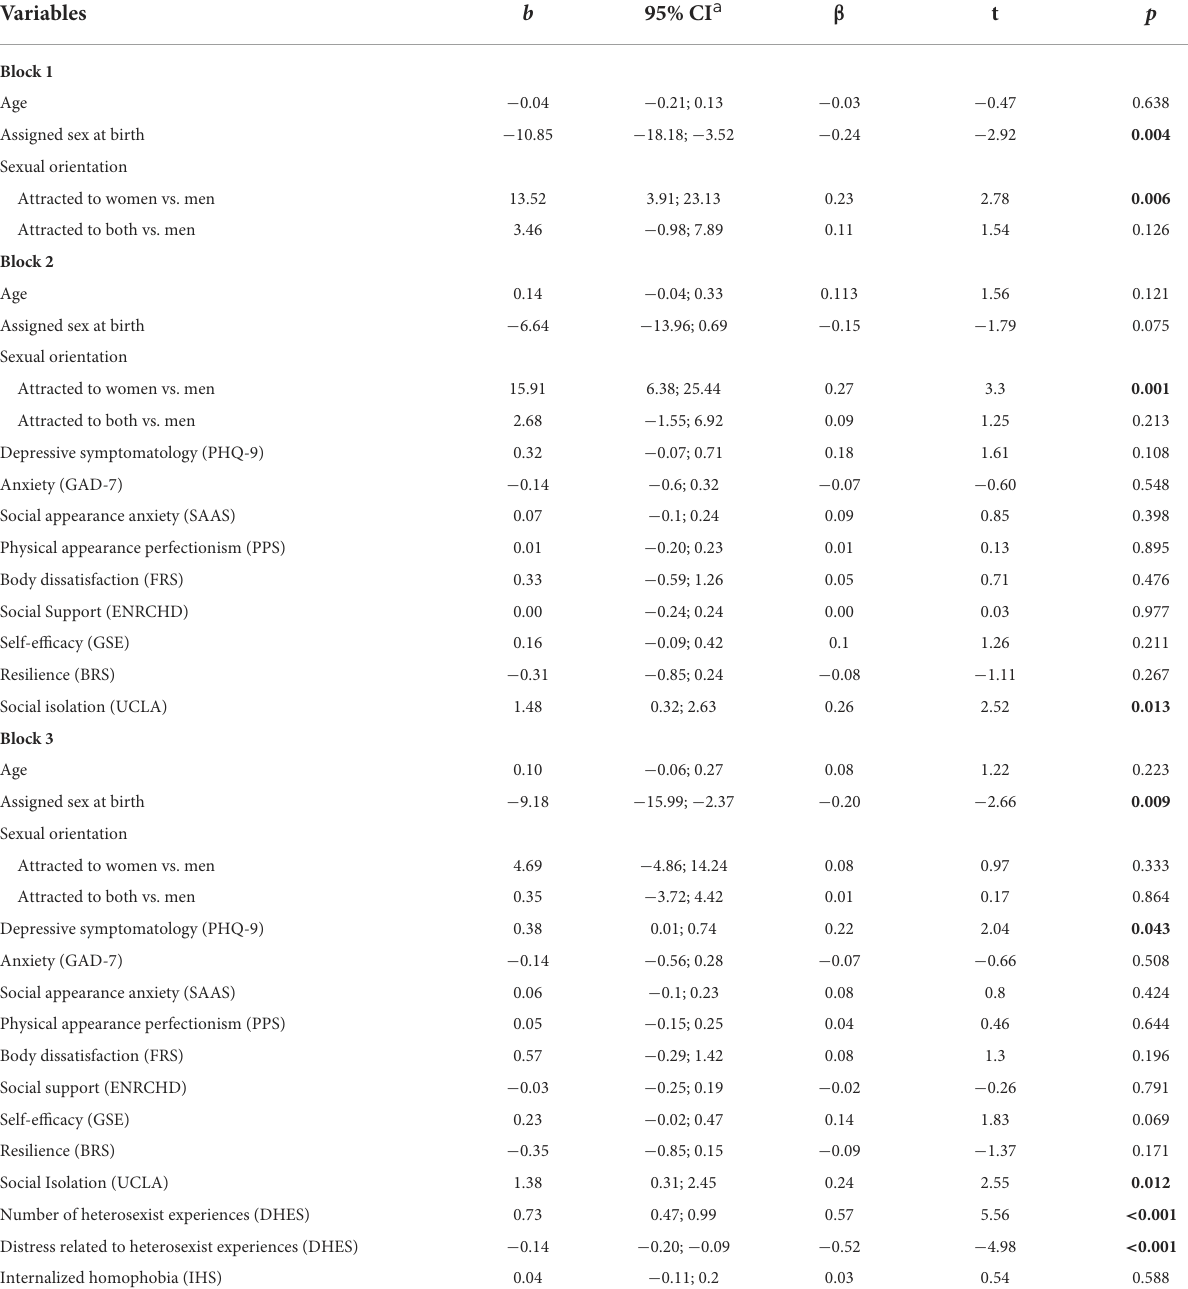
TABLE 2 Summary of the multiple hierarchical regression analysis predicting eating attitudes ( N =